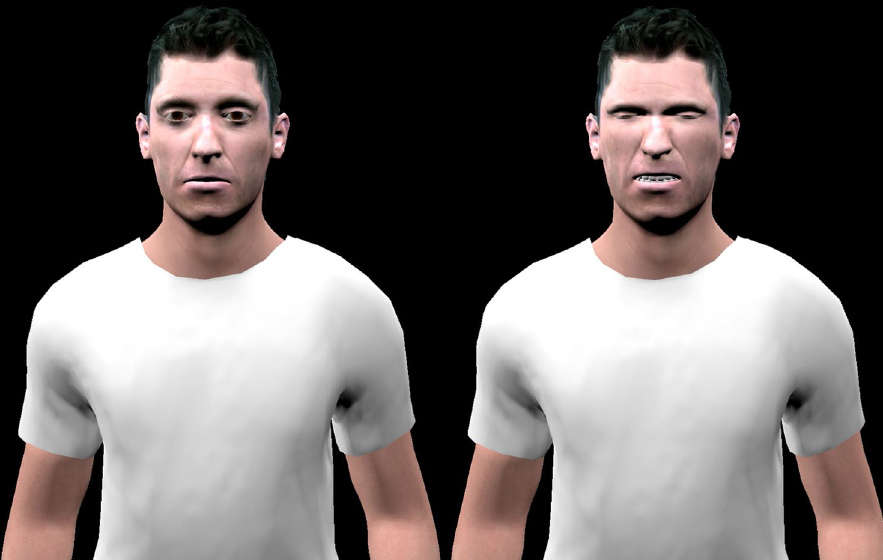
Figure 1. Left side: virtual character at the beginning of the clip (neutral expression). Right side: virtual character expressing pain ( AUs at 60% of maximum contraction) (Fig. 1 was drawn using Blender 2.79 http:// www. blend er.